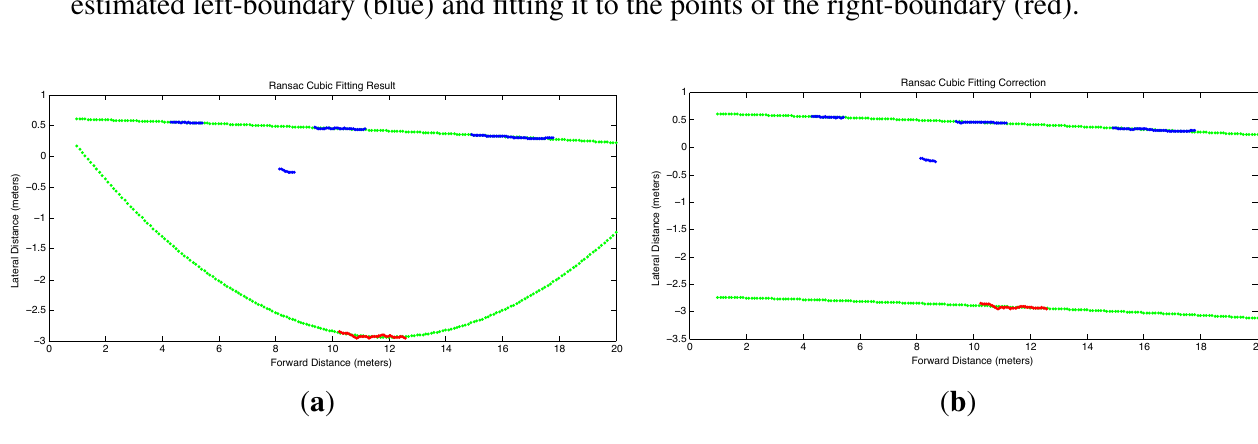
Figure 7. Example of the correction procedure for erroneous MSAC fitting results. ( a ) Erroneous MSAC fitting due to severe occlusion of the lane’s right-boundary (red); ( b ) Correction of the lane’s estimated right-boundary by vertically shifting the lane’s estimated left-boundary (blue) and fitting it to the points of the right-boundary